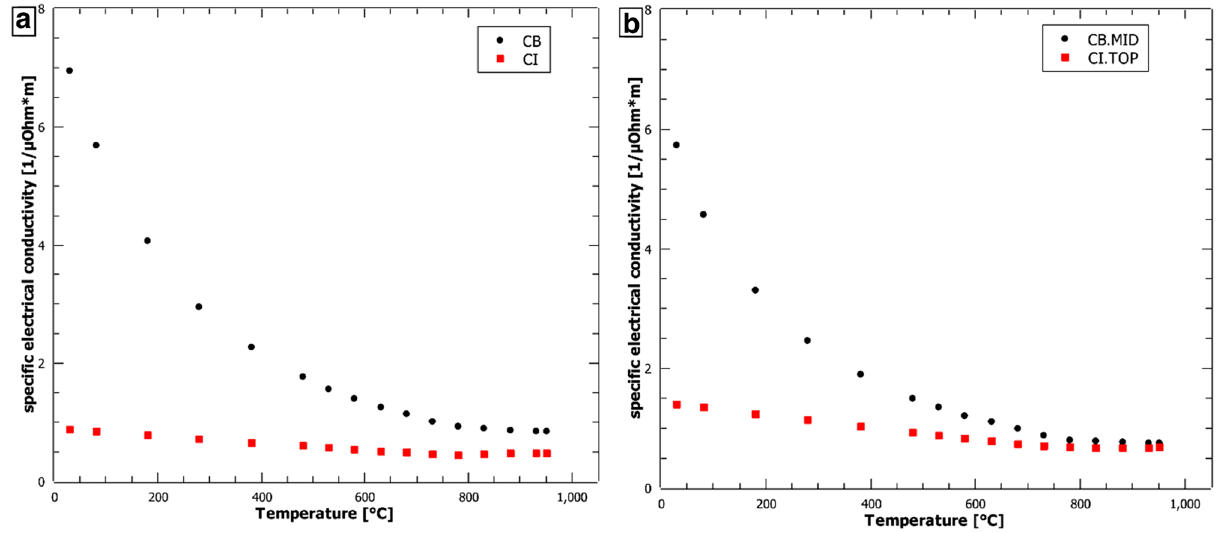
Fig. 6 Comparison of electrical conductivity for both CB and CI over temperature range from room temperature to 950 °C in a new condi- tion ( a ) and in "end of service life"-condition ( b )